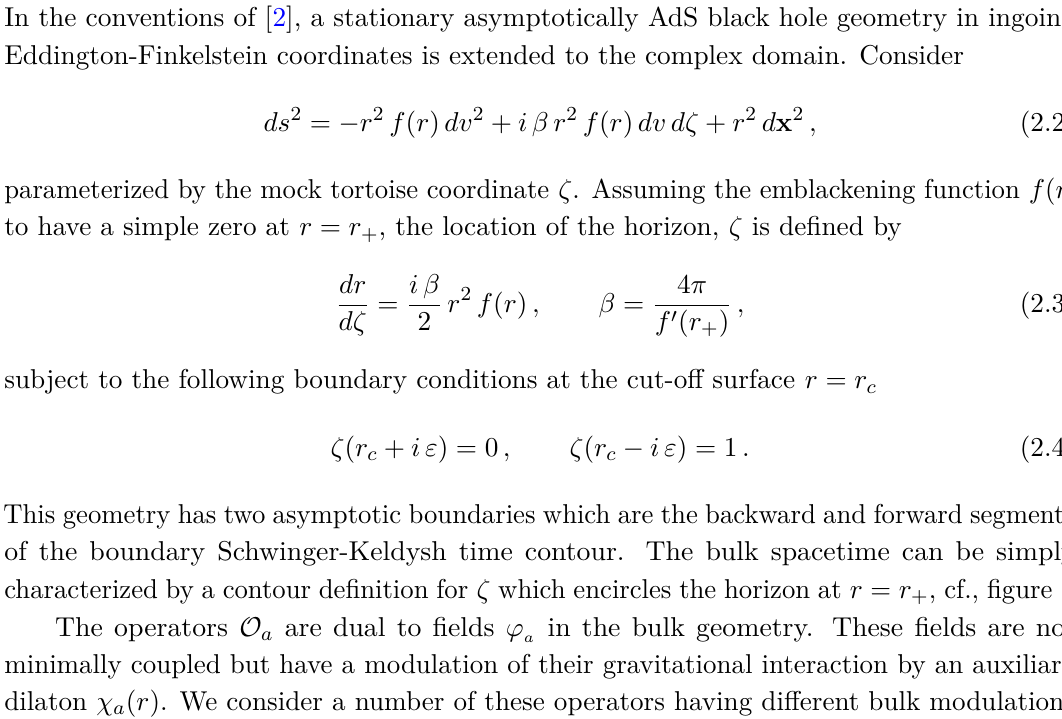
Figure 1 . The contour picked by the grSK geometry in the complexified r plane with the ingoing time coordinate v kept fixed. The contour encircles the branch point at the horizon r = r clockwise starting from left SK boundary (denoted L) at r (denoted R) at r c − iε